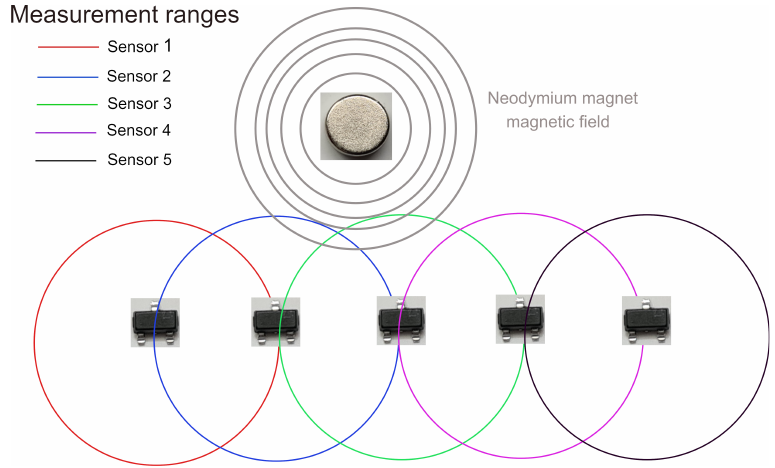
Figure 5. Array configuration of the magnetic sensors and their sensing ranges.